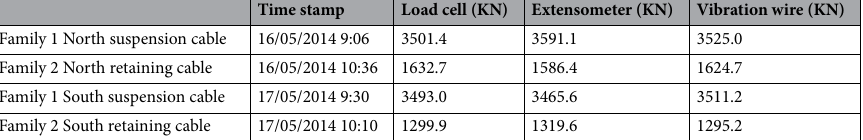
Table 2. Effort facilitated by each of the structural monitoring techniques